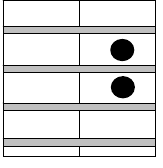
Figure 10. Application of